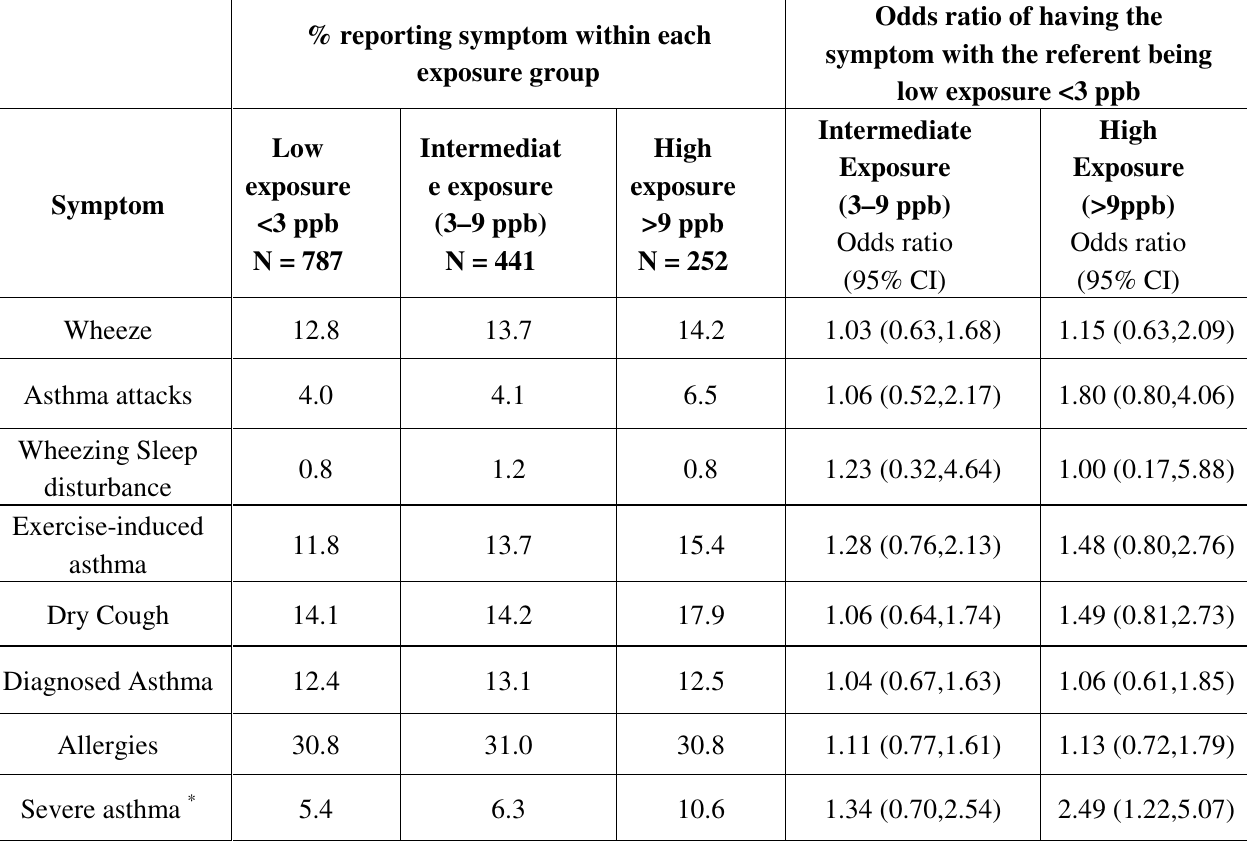
Table 4. Odds ratios for reporting symptoms relative to low exposure < 3